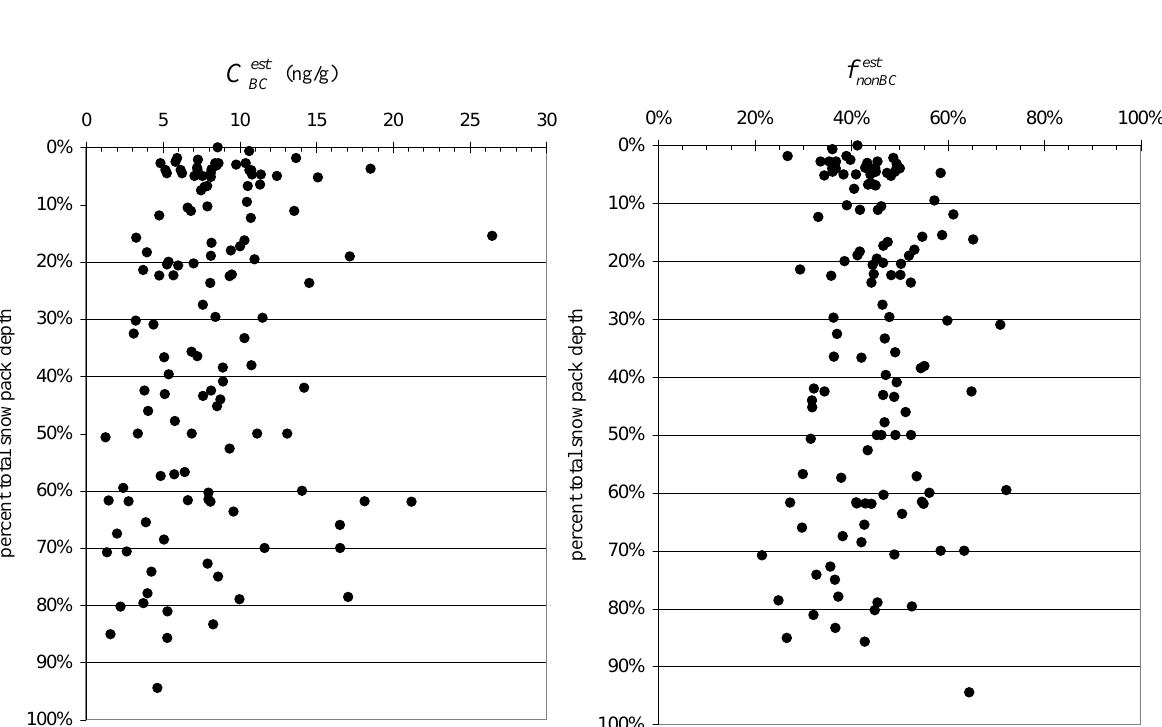
Fig. 9. Profiles from the 2009 Canadian Arctic measurements from 24 sampling sites (Fig. 3) of snow BC concentrations (left) and the fraction of absorption due to non-BC constituents (right). Side-by-side pairs have been averaged together, and the deepest snow samples excluded to avoid contamination by soil or sea-ice algae. Across all 24 sites the snowpack depth was 30 ±